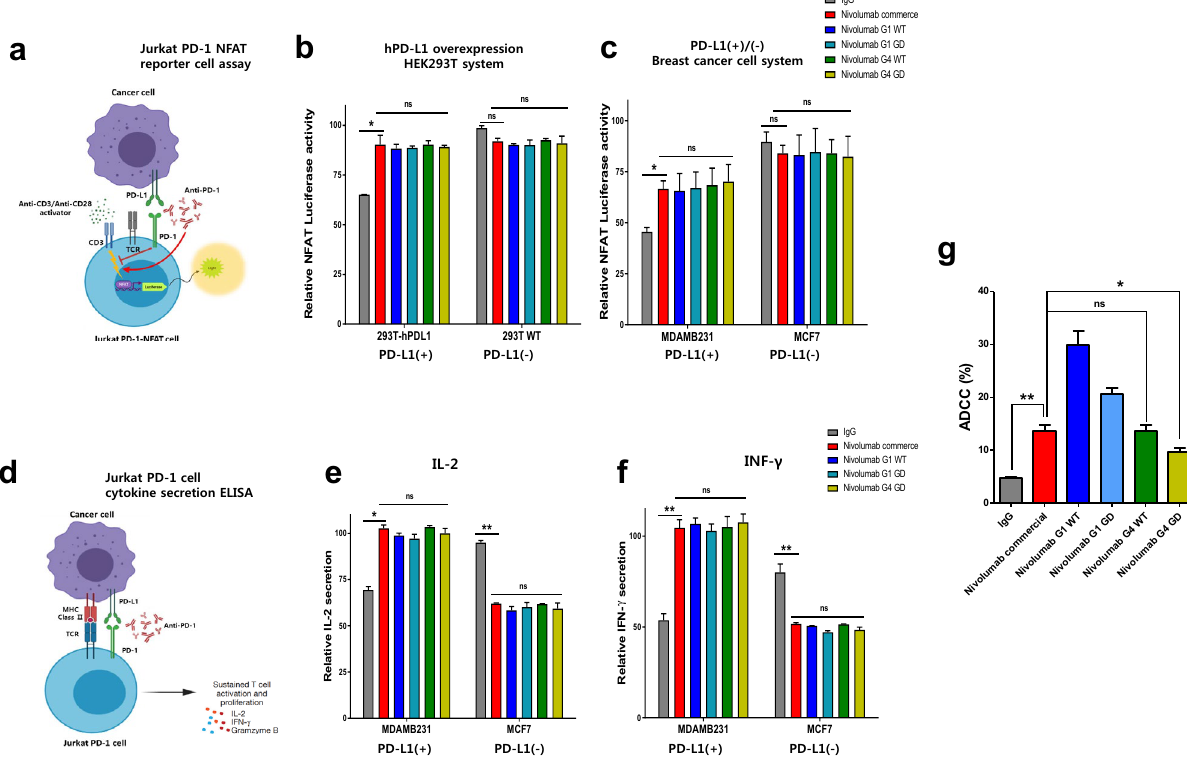
Figure 2. Comparable PD-1-blockade activity and reduced ADCC efficacy of CHO-GD nivolumab. Graphs of Jurkat PD-1 NFAT reporter cell system ( a ) and cytokine secretion of Jurkat PD-1 cells ( d ) were used to analyze the PD-1 blocking function of CHO-GD nivolumab. ( b,c ) PD-1 blocking activity of CHO-GD nivolumab (30 μg/mL) was confirmed via NFAT luciferase assay. Jurkat PD-1-NFAT cells were co-cultured with PD-L1 (+) ( b ) or PD-L1 (−) ( c ) cells and stimulated with an anti-CD3/anti-CD28 activator. Luciferase activity was measured 6 h after stimulation. ( e,f ) IL-2 ( e ) and IFN-γ ( f ) secretion activities of CHO-GD nivolumab. Jurkat PD-1 cells were co-cultured with breast cancer cell lines and treated with an anti-CD3/anti-CD28 activator and 30 μg/mL of each antibody. After 24 h of incubation, cell media were used for the ELISA. IgG was used as a negative control. ( g ) PD-1 expressing T cell cytotoxicity by CHO-GD nivolumab. ADCC performed by 10 μg/mL each antibody was analyzed using calcein-loaded Jurkat PD-1 cells and PBMCs from healthy donors as effector cells (1:3 target cell ratio: effector cell). Cell death rate was deducted from the live cells percentage, which was calculated by the numbers of calcein-containing cells 4 h after antibody treatment. WT IgG1 nivolumab and IgG were used for positive and negative control, respectively. Statistical significances were indicated as *p ≤ 0.05, **p ≤ 0.01, and ***p ≤ 0.001, respectively. ns, not